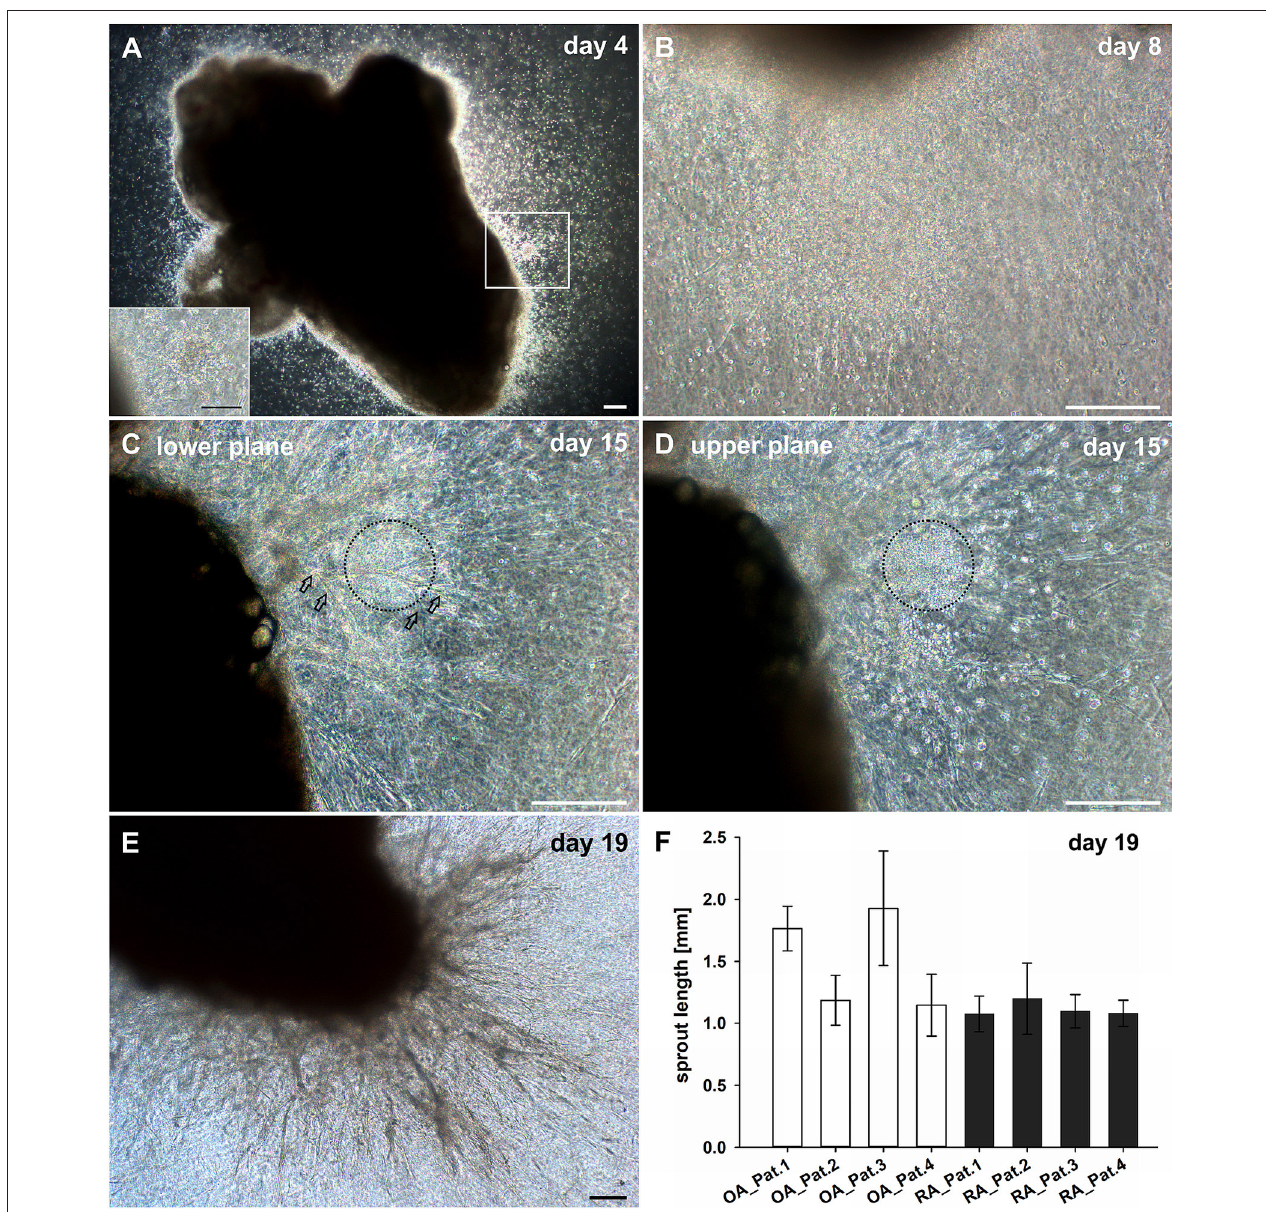
FIGURE 1 | Culture of synovial tissue in fibrin gels leads to the development of vascular structures preceded by egress of inflammatory cells into the 3D matrix. (A) Mononuclear cells present at day four around the embedded explant tissue forming a cluster (insert, represents magnified area of white box). (B) Dense infiltration of mononuclear cells invading the fibrin gel accompanied by spindle-shaped cells after 1 week of culture. (C) Neo-vessels emanating from the synovial tissue after 2 weeks of culture (open arrows). (D) Vascular sprouts develop in close proximity to inflammatory cells (black dashed circles). Images (C,D) represent two different planes of the same area within the gel ( C , lower plane; D , upper plane). (E) A complex vascular network is present within the fibrin gel after 19 days of explant tissue culture. (A–E) Sequential phase contrast microscopy images of representative inflammatory OA explant tissue in 3D fibrin gel taken on indicated days. (F) Maximum length of vascular sprouts measured in representative explant cultures of four OA and RA patients, respectively. Scale bars, 200 µ